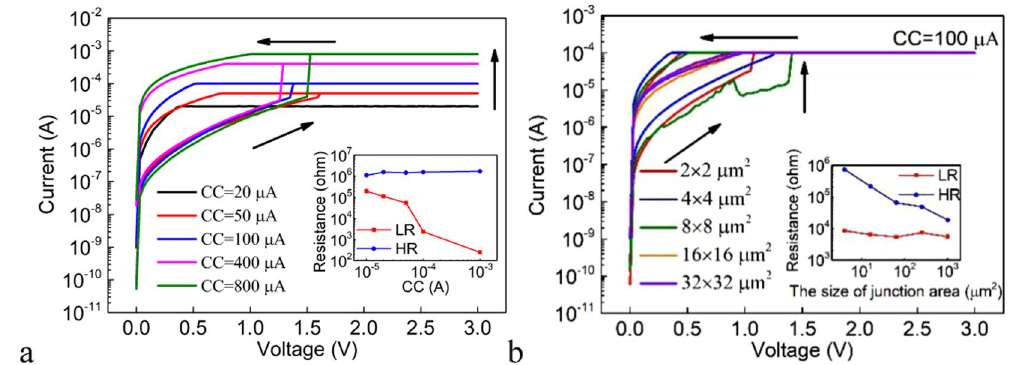
Figure 4. ( a ) The DC I-V curves of the SET processes under different CCs for the Pt/Ge 2 Sb 2 Te 5 /Te cell. Inset: the dependence of the LR and HR on the CC for the Pt/Ge 2 Sb 2 Te 5 /Te cell. ( b ) The DC I-V curves of the SET processes for Pt/Ge 2 Sb 2 Te 5 /Te devices with different sizes of the junction areas under the SET CC of 100 μ A. Inset: the dependence of the LR and HR on the size of the junction area for the Pt/Ge 2 Sb 2 Te 5 /Te